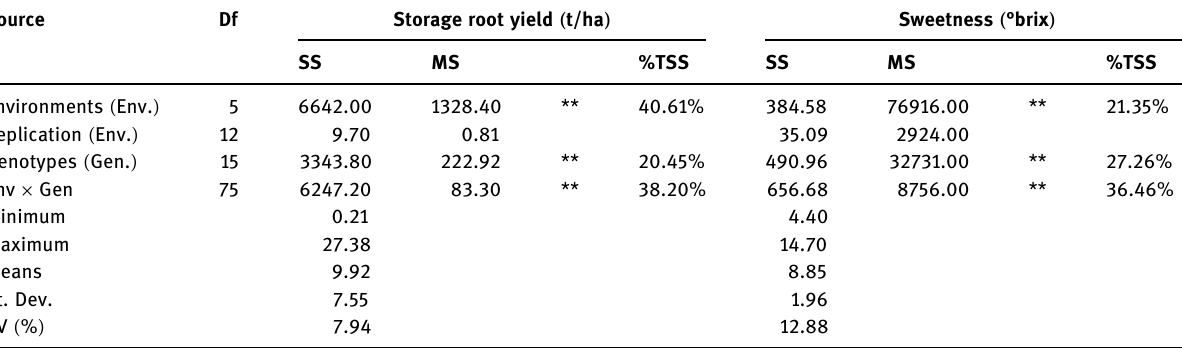
Table 2: Combined ANOVA for 16 honey sweet potato genotypes storage root yields and sweetness evaluated in six locations in West Java, Indonesia Source